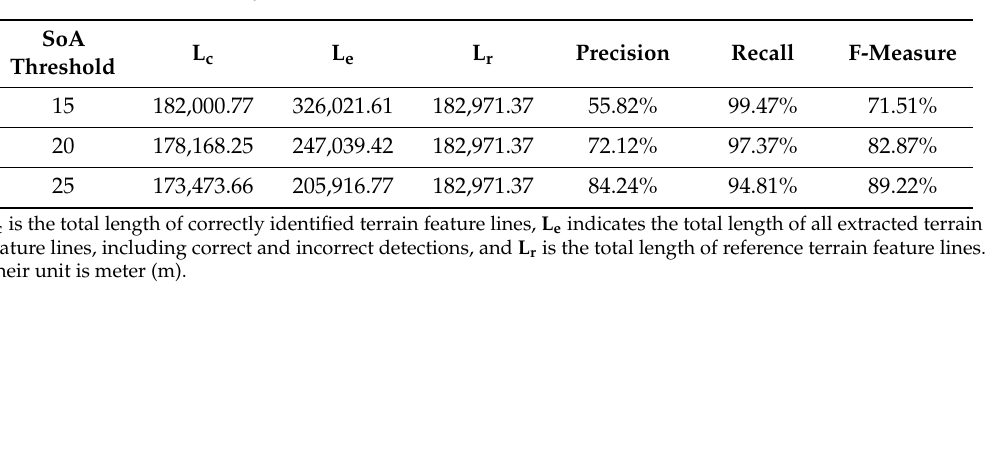
Table 2. Accuracy of terrain feature lines with di ff erent SoA thresholds in